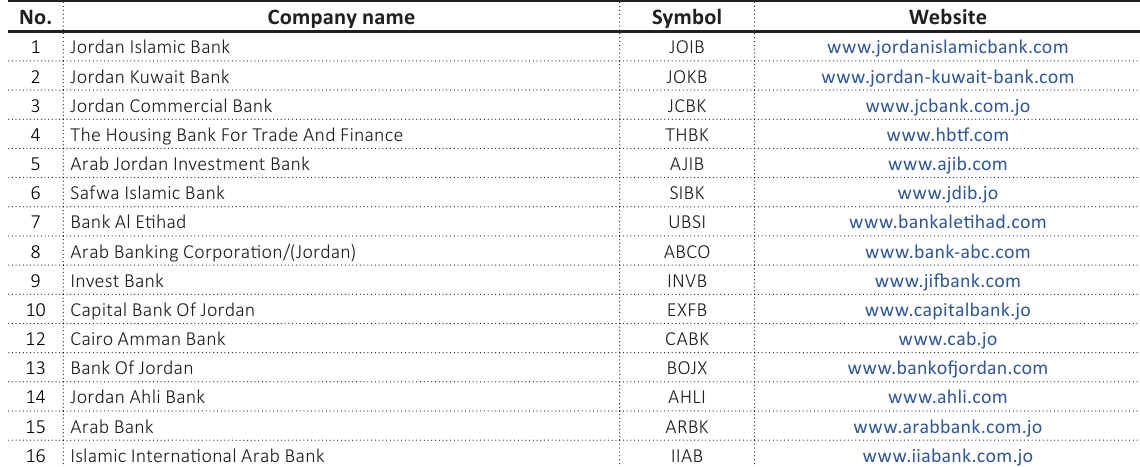
Source: Data obtained from the ASE